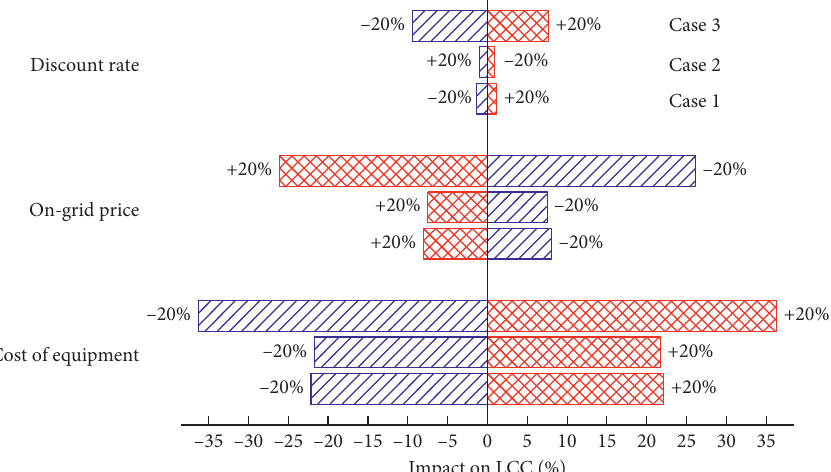
Figure 5: Sensitivity analysis considering economic aspects of three